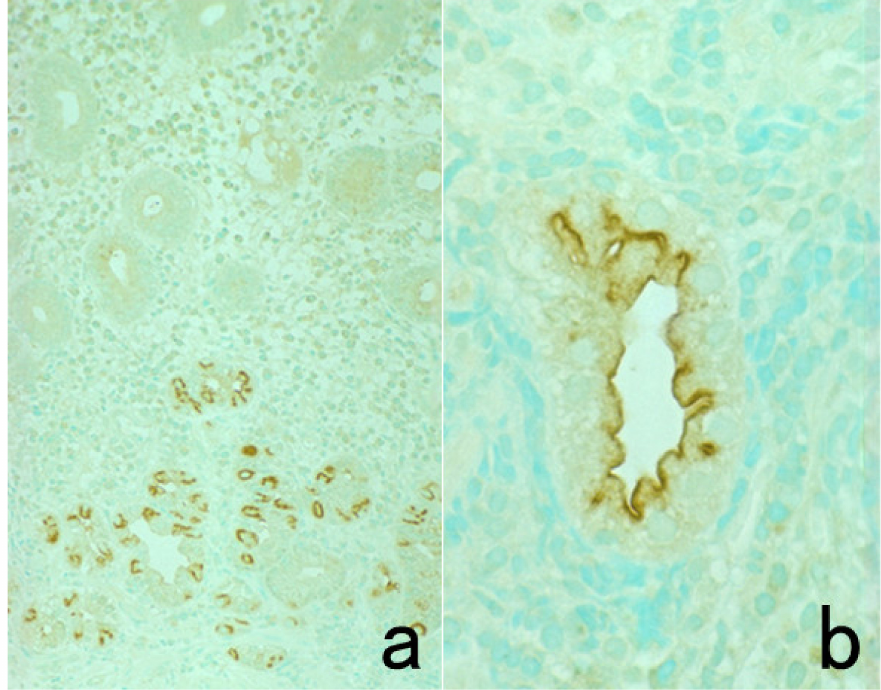
Figure 64. Images of gastric parietal cells in FFPE sections with the serum of a patient with type A (autoimmune) gastritis (( a ): low power, ( b ): high power). The patient’s 1:20 diluted serum, containing autoantibodies against proton pump (H + , K + -ATPase) molecules, decorates C-shaped intracytoplasmic structures (secretory canaliculi) in the acid-secreting parietal cells. The nuclei were counterstained with methyl